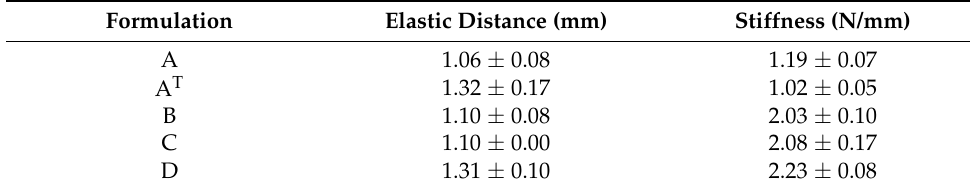
Table 7. Summary results of three-point